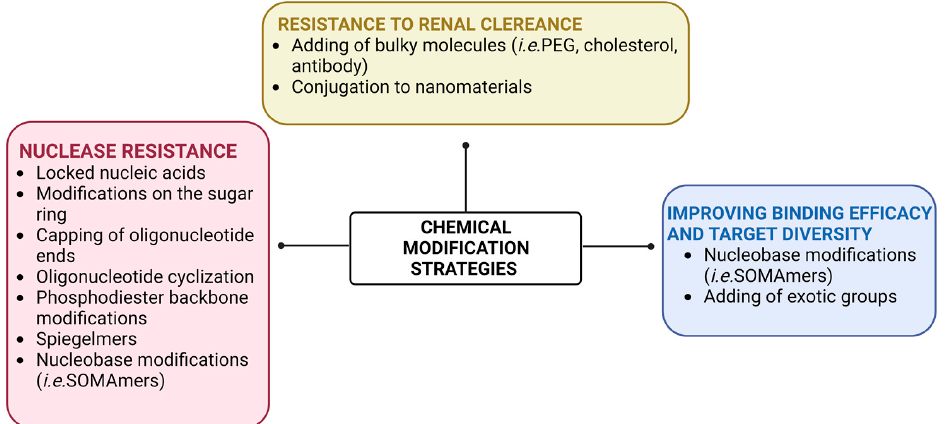
Figure 3. Schematic representation of the most common strategies for chemically modifying ap- tamers in order to improve their clinical applicability. Created with BioRender.com (accessed on 2 March 2023).